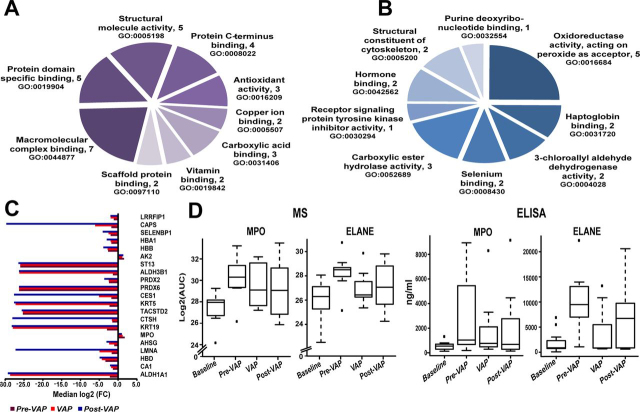
Analysis of functional enrichment and protein levels of differentially abundant proteins.A, GO molecular function analysis of proteins only present in Baseline (at day of intubation). B, GO molecular function analysis of downregulated proteins in pre-VAP and VAP positive relative to Baseline. C, Median log2(FC) of protein abundance for 21 significant proteins in pre-VAP (dark red), VAP positive (red), and post-VAP (blue) compared with Baseline. D, Measurement of MPO and ELANE levels in VAP patients using MS aided relative abundance, log2(AUC) (left) and ELISA (ng/ml of ETA) (right).